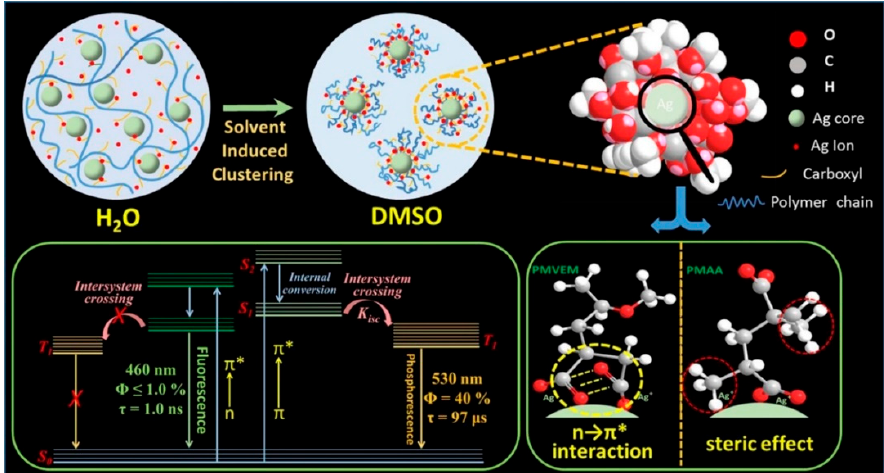
Figure 14. Schematic illustration of the solvent-induced clustering process of Ag NCs (top) depending on the unique molecular structure of the polymer used as a template for the synthesis of Ag NCs (bottom-right) and the energy-level structure of Ag NCs in water solution and DMSO solution (bottom-left). Reprinted with permission from Ref. [88]. Copyright (2017) American Chemical Society.